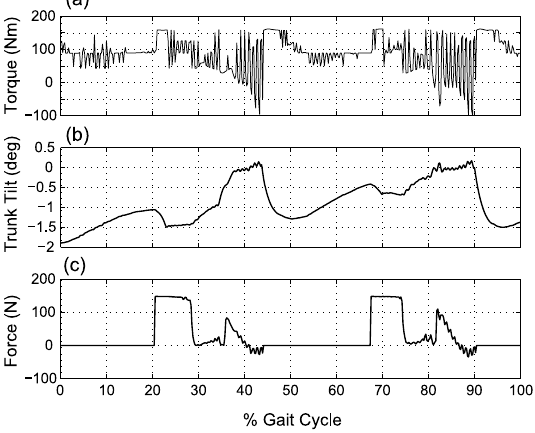
Fig. 7. Arm-support results: (a) output from the torque controller, (b) Trunk tilt or actual output, and (c) output from force